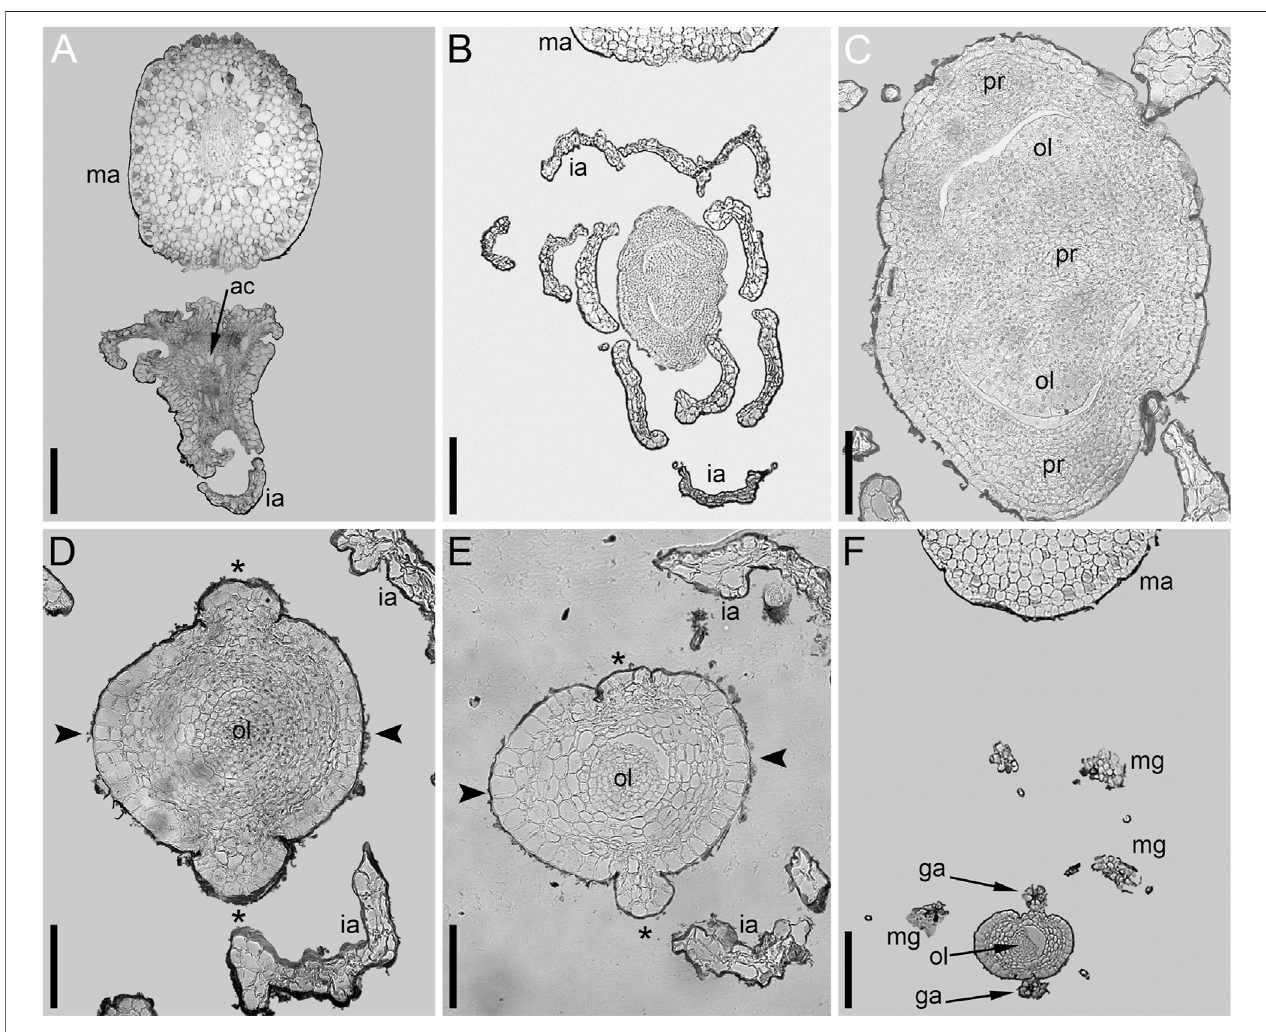
FIGURE 7 | Ascending series of transverse anatomical sections of pistillate fl ower of Ceratophyllum demersum with two glandular gynoecial appendages and basally bilocular gynoecium (LM). A general view of this fl ower is shown in Figure 3D . The fl ower has been serially sectioned after taking SEM images. (A) Level of attachment of involucral appendages. (B,C) Bilocular region of the gynoecium. Each locule has an ovule. (D – F) Unilocular region of the gynoecium with the third ovule. ArrowheadsinD,Eshowradiiofattachmentofthetwolongdistaloutgrowths(see Figure3D ).AsterisksinD,Eshowradiiofthetwoglandularappendagesthatare visible in (F) . (F) Level of attachment of the two glandular appendages. Scale bars = 300 μ m in (A,B,F) , 100 μ m in (C – E) .